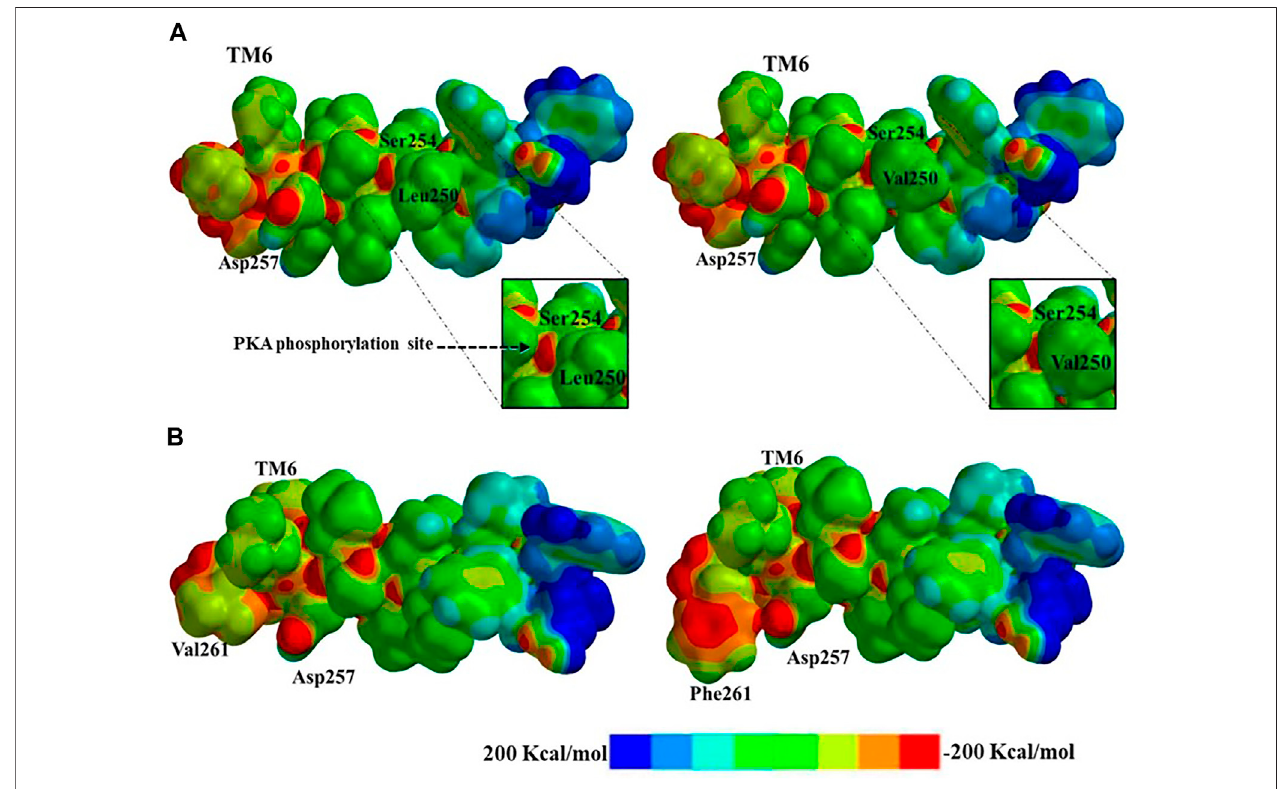
FIGURE 5 | Electrostatic potential map representation: (A) electronic distribution and phosphorylation blockage of wild type (left) and PS1 mutation Leu250Val (right) to putative protein kinase A (PKA) phosphorylation; (B) electronic distribution and resulting steric clash of the substitution from wild type (left) to PS1 mutation Val261Phe (right) due to the aromatic electronic effect in the possible interactions with the substrate. Electronic distribution within the range of − 200 Kcal/mol to 200 Kcal/mol is represented by an eight-color